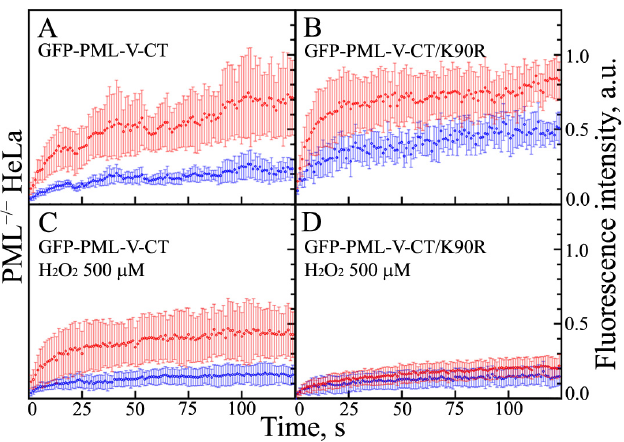
Figure 5. Dynamic properties of the condensates formed by the C-terminal domain of PML-V isoform and its mutant form with the K490R amino acid replacement in PML − / − HeLa cells. EGFP fluorescence recovery after photobleaching of C-terminal domain of PML-V isoform. Panels ( A , C ) present WT C-terminal domain of PMLV isoform and Panels ( B , D ) presents its mutant form with amino acid replacement K490R in normal (Panels ( A , B )) and stressed (Panels ( C , D )) conditions. The curves of the photoreduction of PML isoforms in the composition of “small” and “large” PML bodies are shown in red and blue. Solid curves represent the fit of the FRAP data in the framework of the mono-exponential approximation. The standard deviations of the data are shown by error bars of the corresponding